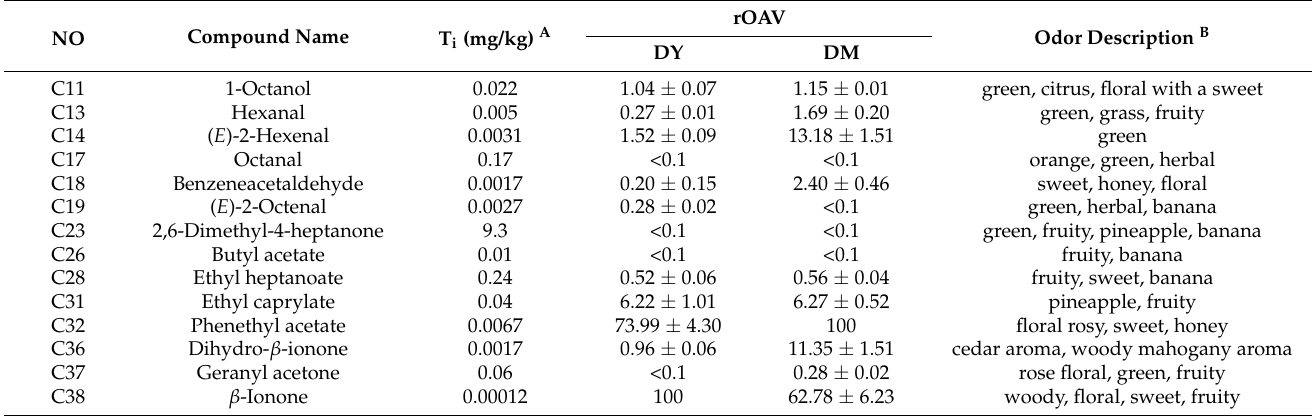
Table 3. rOAV for volatile aroma compounds in D. delavayi fruit of varying maturities.